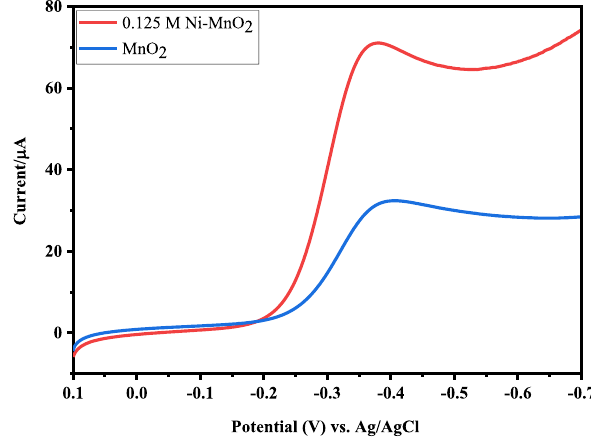
Fig. 13 LSV sketch of un-doped MnO at 5 mVs −1 scan